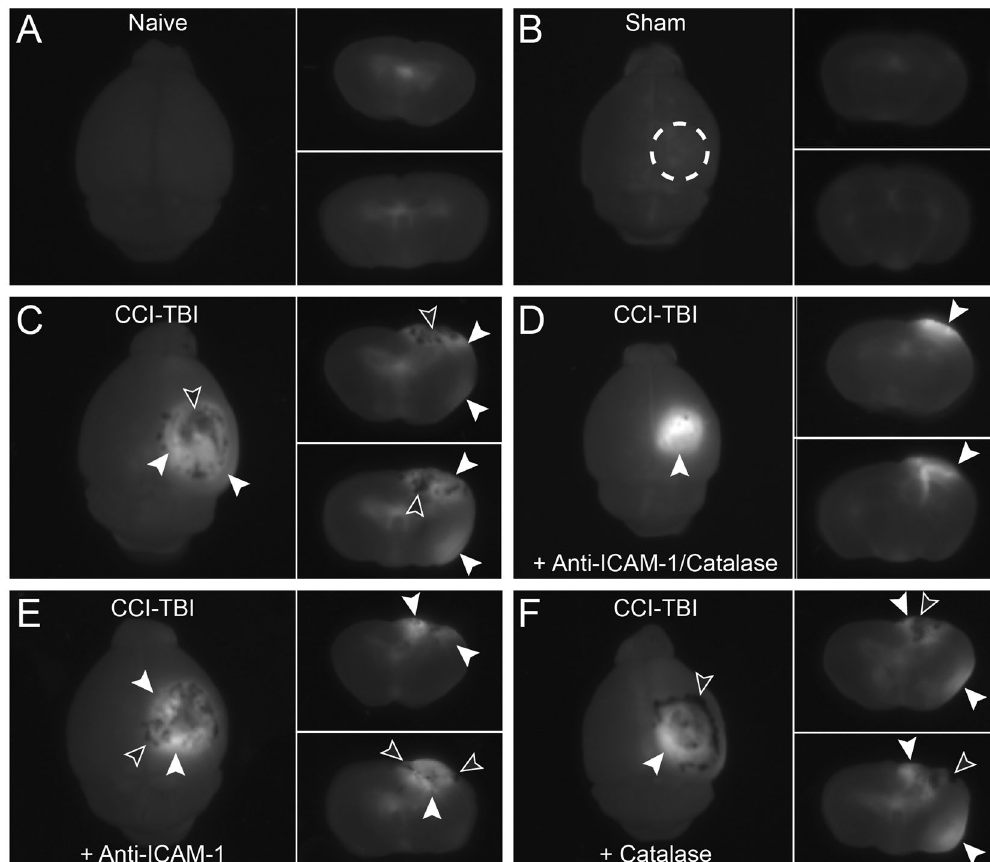
Figure 5. In vivo sodium fluorescein assay further elucidates changes in BBB permeability with increased barrier permeability following moderate CCI-TBI and rescue of barrier function with anti-ICAM-1/catalase. Sodium fluorescein was administered IV at 48 hrs post-CCI-TBI to evaluate barrier integrity at this time point. The small molecular weight fluorescent tracer was allowed to circulate for 15 min before tissue perfusion and collection. Fluorescent images captured using short wave UV light demonstrate sodium fluorescein leakage into brain tissue in naive (( A ), no craniectomy) and sham ( B ) mice and mice sustaining moderate CCI-TBI events at 48 hr following injury ( C ) CCI-TBI only, D: CCI-TBI + Anti-ICAM-1/catalase, ( E ) CCI-TBI + anti-ICAM-1 antibody, and F: CCI-TBI + catalase). The dashed circle in B demarcates where the craniectomy was performed. Sodium fluorescein leakage into the brain extends beyond the area of impact following moderate CCI-TBI, highlighted by white arrowheads. Black arrowheads indicate areas of hemorrhage, edema, or swelling of the brain following injury. Coup and contrecoup mechanisms of injury resulting from CCI-TBI can be appreciated by comparing sodium fluorescein signal detection in the area of impact (top of brain section) to the base of the brain directly opposite of the area of impact in CCI-TBI and CCI-TBI + Catalase groups ( C , F